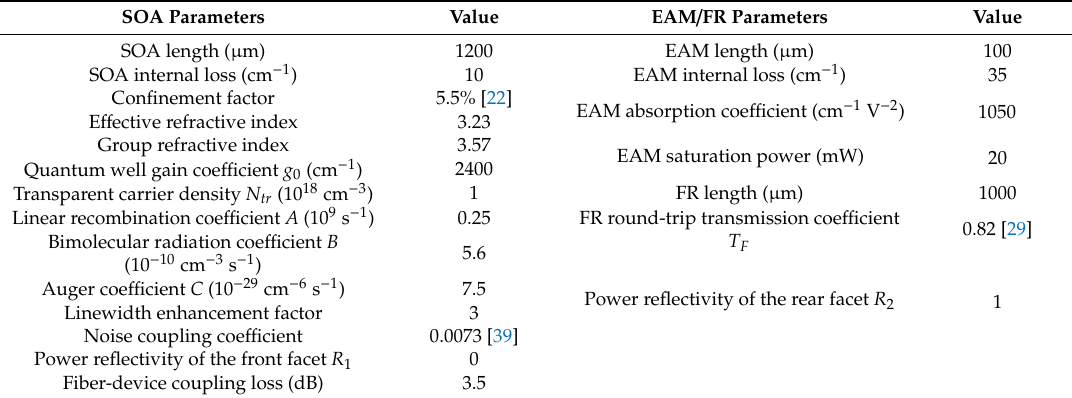
Table 1. Parameters of the Proposed PD